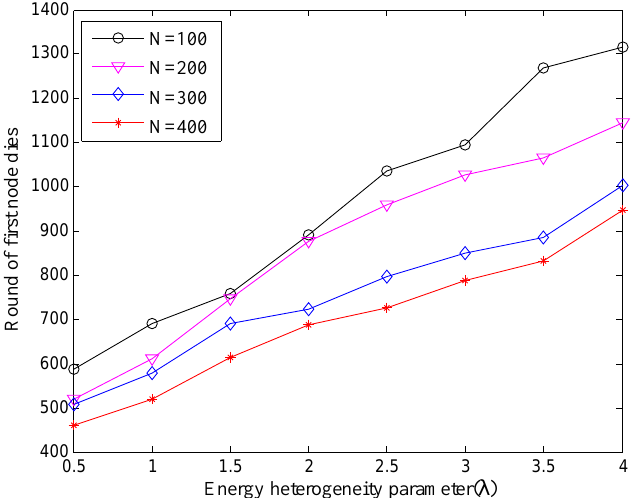
Figure 3. The stable period with different number of nodes under different energy heterogeneity factor.